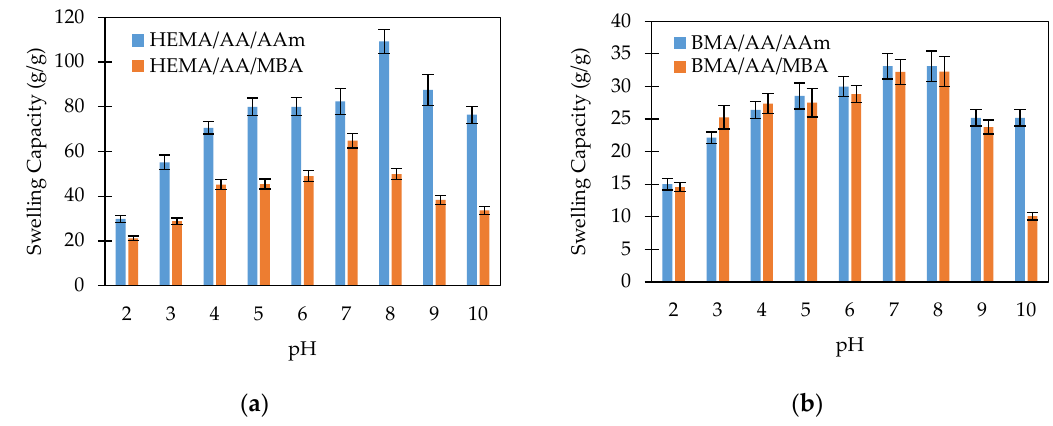
Figure 4. Swelling capacity of the hydrogels as a function of the pH. Effect of crosslinking: ( a ) Comparison of HEMA/AA/AAm and HEMA/AA/MBA hydrogels; ( b ) Comparison of BMA/AA/AAm and BMA/AA/MBA hydrogels.